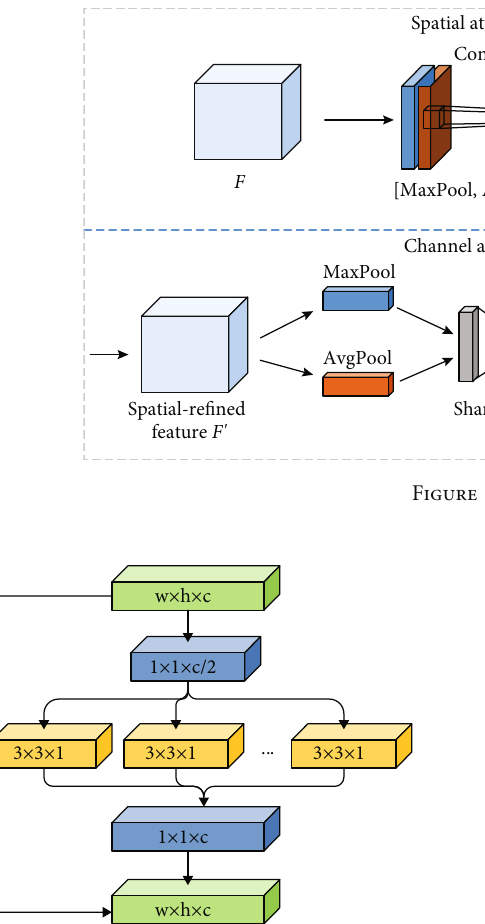
Figure 8: Grouping bottleneck.